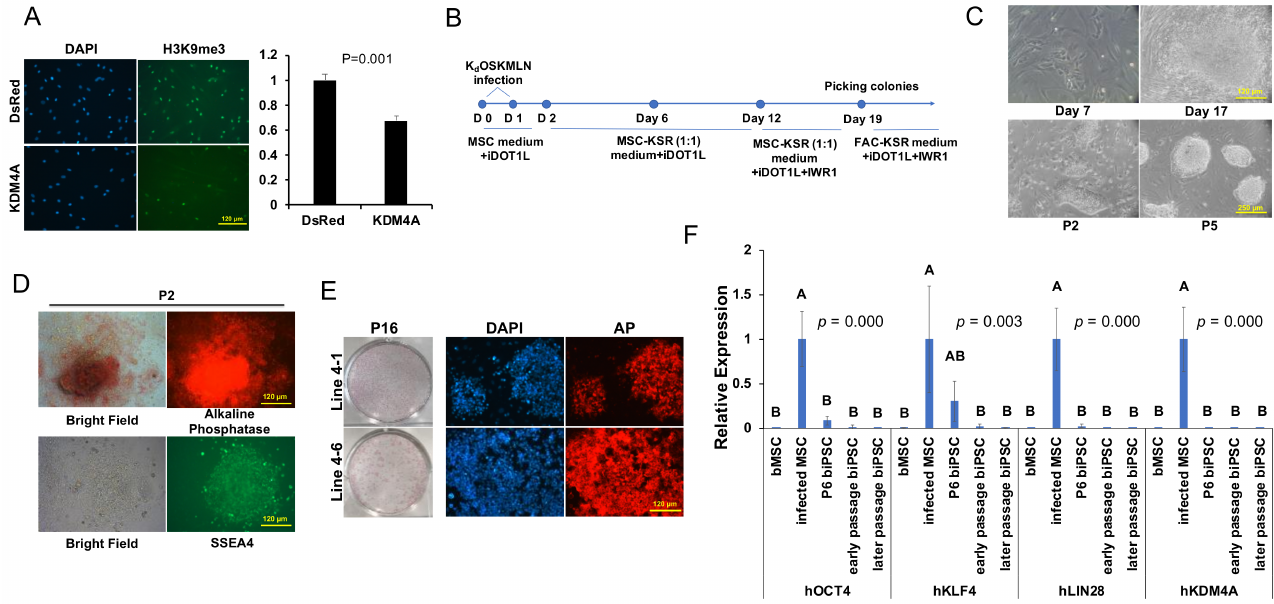
Figure 1. Induction of biPSCs. ( A ): Left Panel: Immunostaining of H3K9me3 expression in bMSCs infected with retro- viral vector control or KDM4A. Bar = 120 µ m. Right Panel: Relative fluorescence intensity for H3K9me3 in bMSCs. Bar = mean ± sd, n = 3. Student’s t-test was used for data analysis. ( B ): Scheme of reprogramming of the bovine MSCs. ( C ): Upper panel: Development of iPSC colonies at day 7 and 17 of retroviral K d OSKMLN infection of bMSCs, bar = 120 µ m. Lower panel: Picked biPSC colonies at P2 and P5, bar = 250 µ m. ( D ): Expression of AP (upper panel) and SSEA4 (lower panel) in P2 biPSC colonies, bar = 120 µ m. ( E ): AP staining of biPSCs expanded in KT medium at P16. Left: Two AP-stained biPSC lines from one well of a 6-well plate. Right: AP-fluorescence from 2 biPSC lines under the microscope. Bar = 120 µ m. ( F ): qRT-PCR for transgene expression in four lines of biPSCs at passage 6 (P6), early passages (Lines 4-1 at P17, 4-6 at P17, 3-2 at P10), and later passages (Lines 4-1 at P43, 4-6 at P25, 3-2 at P29, O4 at P40). Transgene infected bMSCs at 48 h were used as the positive control. Bar = mean ± sd, n = 4. One way–ANOVA with Tukey’s post hoc multiple comparison test was used for data